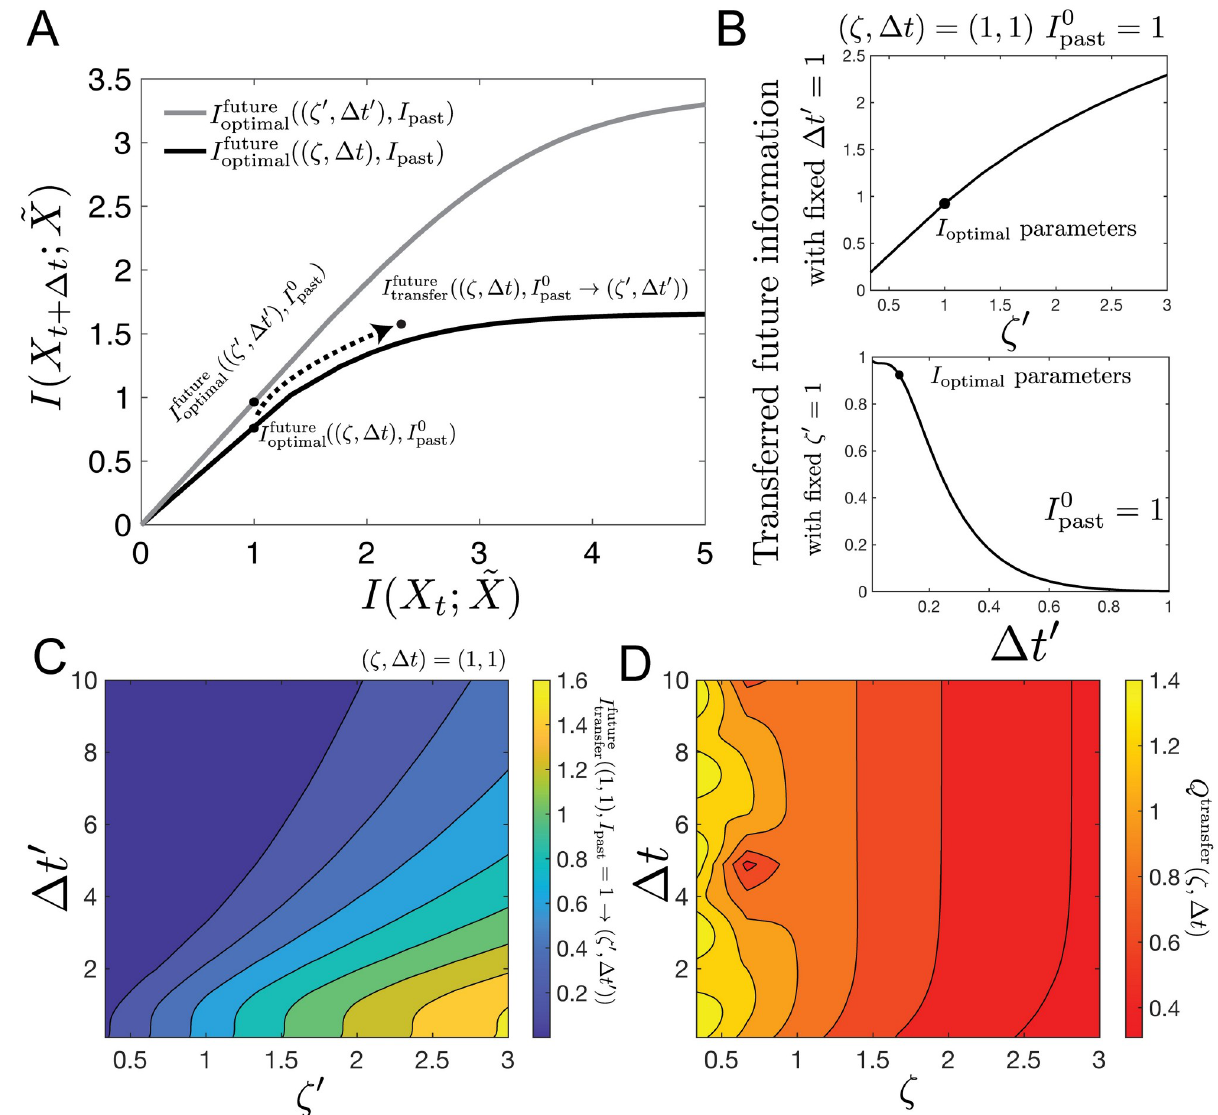
Fig 6. Representations learned on underdamped systems can be transferred to other types of motion, while representations learned on overdamped systems cannot be easily transferred. (a) Here, we consider the information bottleneck bound curve (black) for a stimulus with underlying parameters, ( z , Δ t ). For some particular level of I ¼ I 0 , we obtain a mapping, P ð ~ X j X Þ that extracts some predictive information, past t past denoted I future ðð z ; D t Þ ; I 0 Þ , about a stimulus with parameters ( z , Δ t ). Keeping that mapping fixed, we determine the amount of predictive information optimal past for dynamics with new parameters ( z 0 , Δ t 0 ), denoted by I future ðð z ; D t Þ ; I 0 ! ð z 0 ; D t 0 ÞÞ . (b) One-dimensional slices of I future in the ( z 0 , Δ t 0 ) plane: I future transfer past transfer transfer versus z 0 for Δ t 0 = 1. I 0 ¼ 1 (top), and versus Δ t 0 for z 0 = 1. Parameters are set to ( z = 1, Δ t = 1), I 0 ¼ 1 . (c) Two-dimensional map of I future versus ( z 0 , past past transfer Δ t 0 ) (same parameters as b). (d) Overall transferability of the mapping. The heatmap of (c) is integrated over z 0 and Δ t 0 and normalized by the integral of ðð z 0 ; D t 0 Þ ; I Þ . We see that mappings learned from underdamped systems at late times yield high levels of predictive information for a wide range I future past optimal of parameters, while mappings learned from overdamped systems are not generally